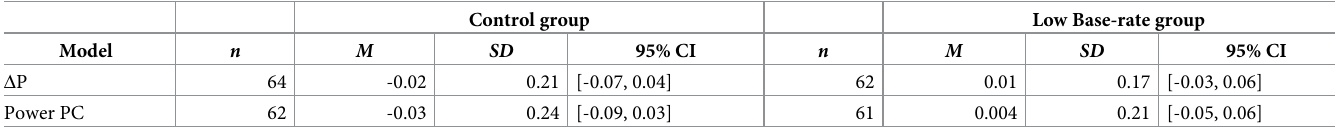
Table 5. Indexes obtained for the two models, Δ P and Power PC, computed from the actual training data in Experiment 2. The models cannot be computed for some participants (due to division by zero errors), so these cases are